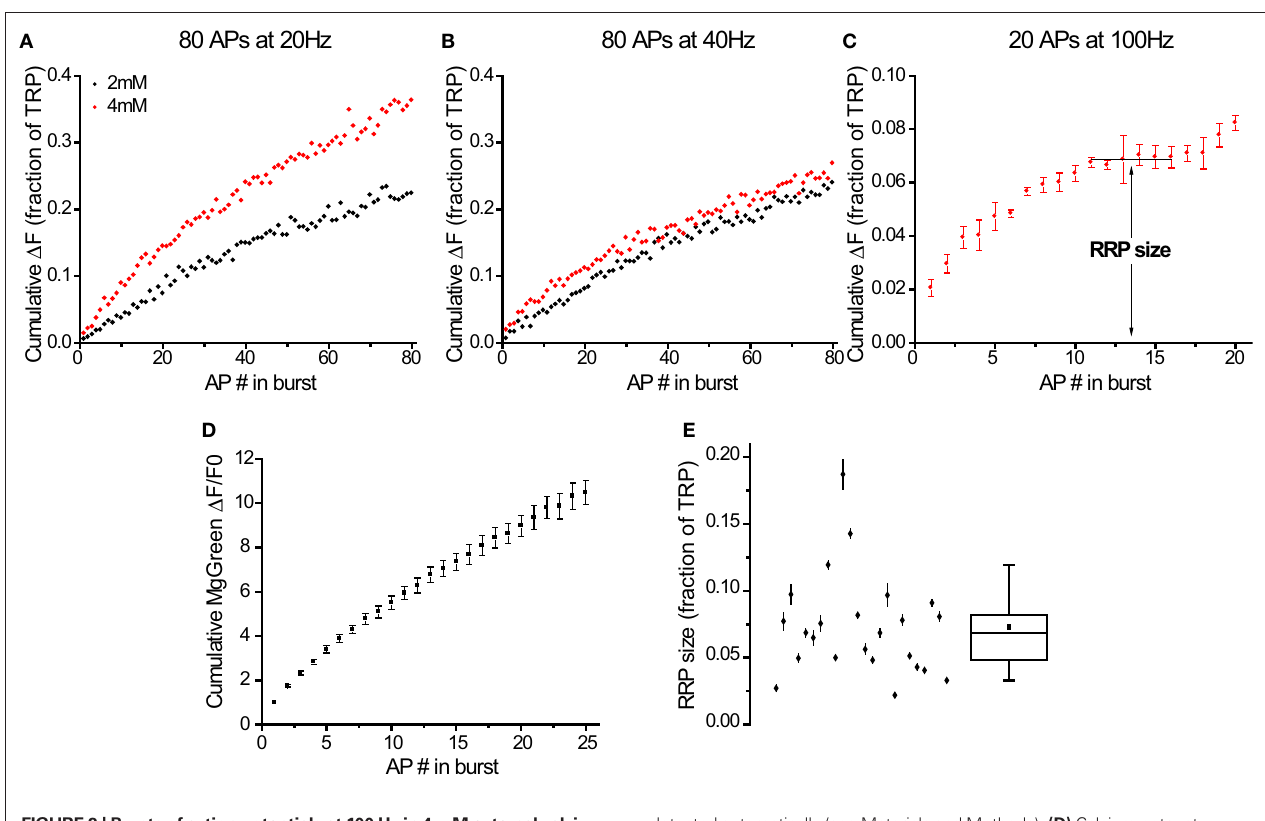
Figure 3 | Bursts of action potentials at 100 Hz in 4 mM external calcium deplete the rrP after exocytosis of ∼ 7% of the TrP. (A–C) Responses to different stimuli in the same cell (average of 11 synapses). Responses to 20 (A) and 40 Hz (B) come from individual trials, response to 100 Hz burst ( C ) is the average of 4 trials. The plateau indicating the depletion of the RRP (C) was